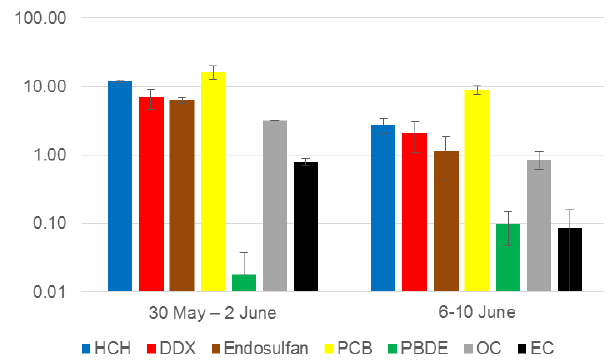
Figure 1. Observed concentrations in air, c a , of pesticides ( (cid:54) 4 HCH, (cid:54) 6 DDX, (cid:54) 3 Endosulfan), (cid:54) 7 PCB, (cid:54) 9 PBDE (pgm − 3 ) , OC and EC (µgm − 3 ) before and after the onset of the south-westerly monsoon in Munnar, India, 2014. Error bars reflect standard deviations. All concentration changes are significant ( p <0.05 level, t test) except for